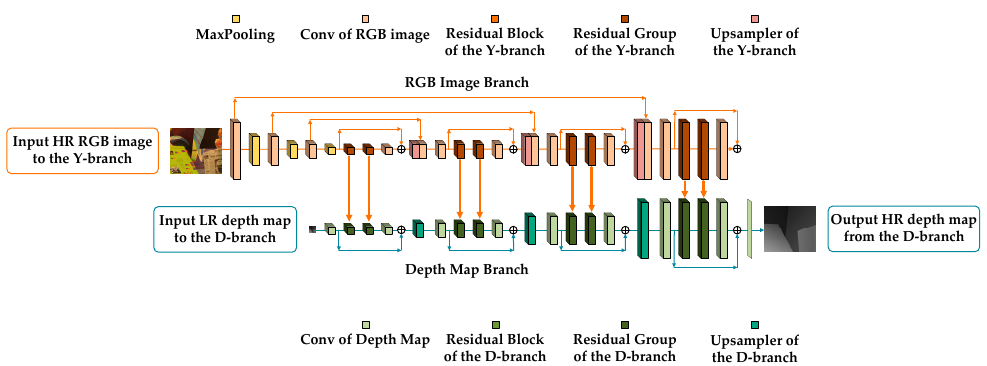
Figure 1. The architecture of our network for 8 × upsampling. HR: High-resolution, LR: Low- resolution.